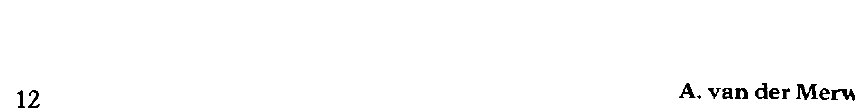
frekwensie en tipe ouditief waarneembare simptome of foute in die spraak van persone met verbale apraksie.